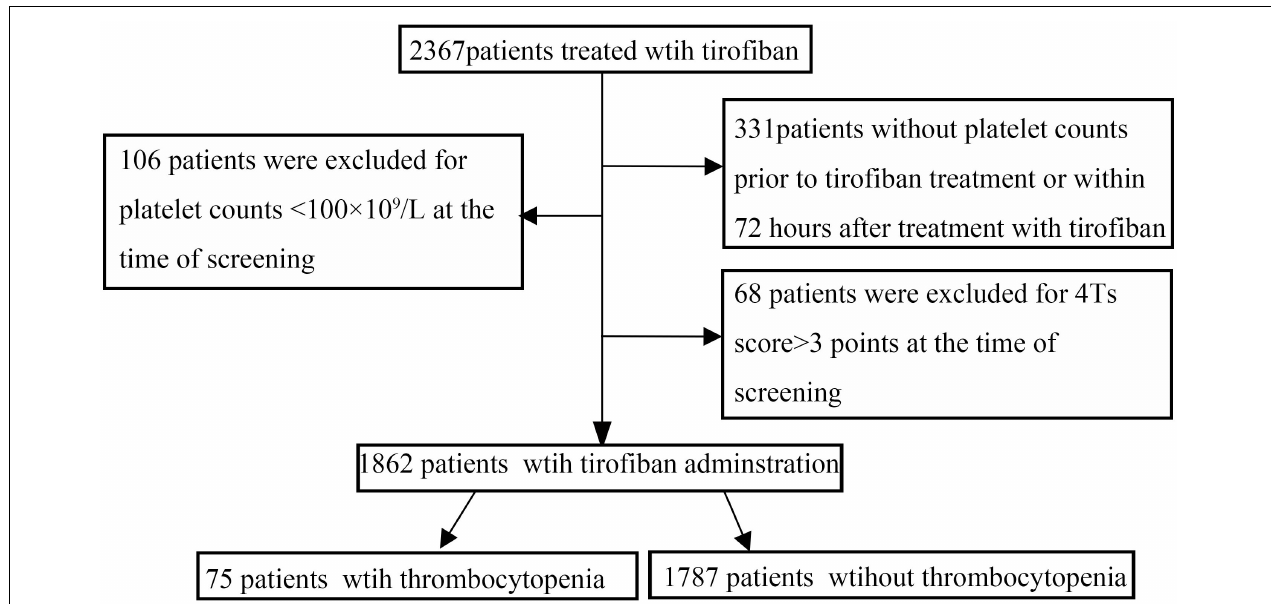
FIGURE 1 | Flow chart depicting numbers of patients who were included in analysis after exclusion criteria. The total included encounters were divided into those with and without tirofiban-induced thrombocytopenia.